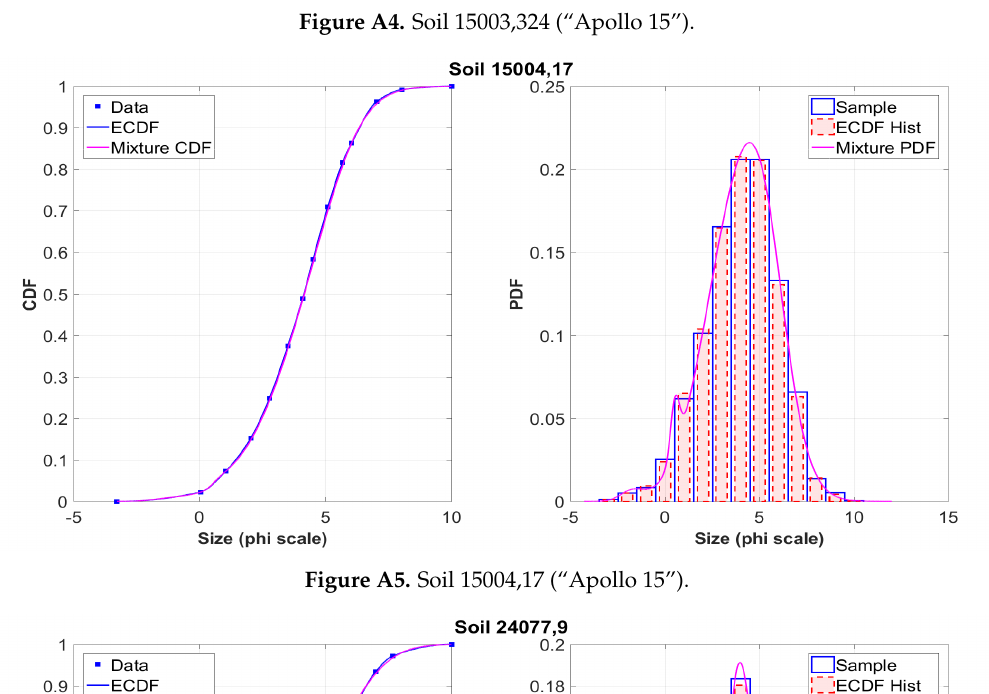
Figure A4. Soil 15003,324 (“Apollo 15”).